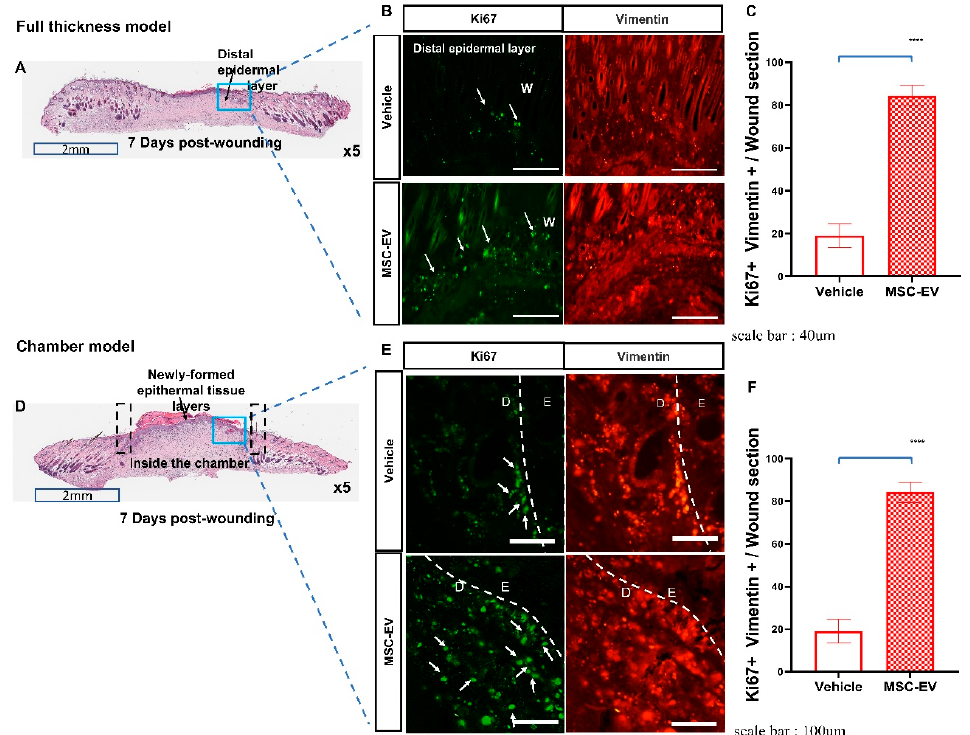
Figure 4. EVs promote fibroblast cell proliferation and migration. ( A , D ) Representative cross- sectional images of H&E-stained mouse dorsal skin with epidermal structures of MSC-EV-treated wounds. Areas marked with black lines represent the Chambers, blue boxes indicate the newly created granulation tissue, and downward arrows indicate the newly formed epidermis. Scale bar: 2 mm. ( B , E ) Ki-67-positive fibroblast cells (GFP-TRITC merged cells) in typical cross-sections of distal epidermal layer of the vehicle group or MSC-EV-treated group. (Panels A,D : magnification, 5×, scale bar: 2 mm), (Panel B : Full thickness wound model, scale bar: 40 μ m), (Panel E : Chamber model, scale bar: 100 μ m). D: Dermal tissue; E: Epidermal tissue; W: wound. ( C , F ) Quantification of the percent- age of fibroblasts expressing the Ki-67 antigen/wound areas. Data represent the mean ± SD. **** p < 0.0001.